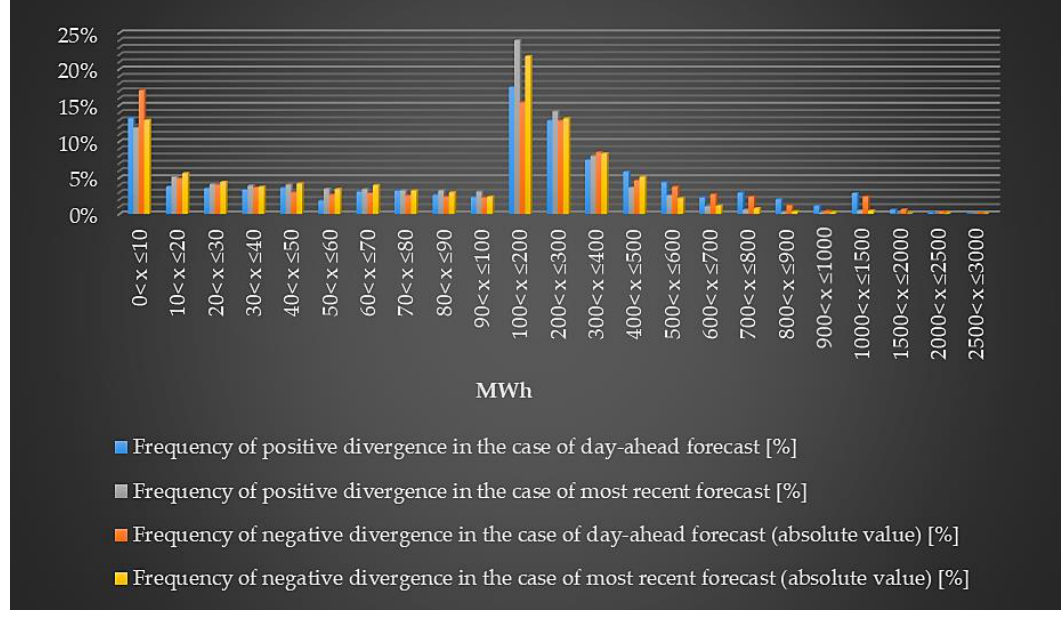
Figure 6. The magnitude of the day-ahead PV energy forecast divergence (24 h-based) compared to the real PV power data for the period of 30/09/2014–30/09/2019.